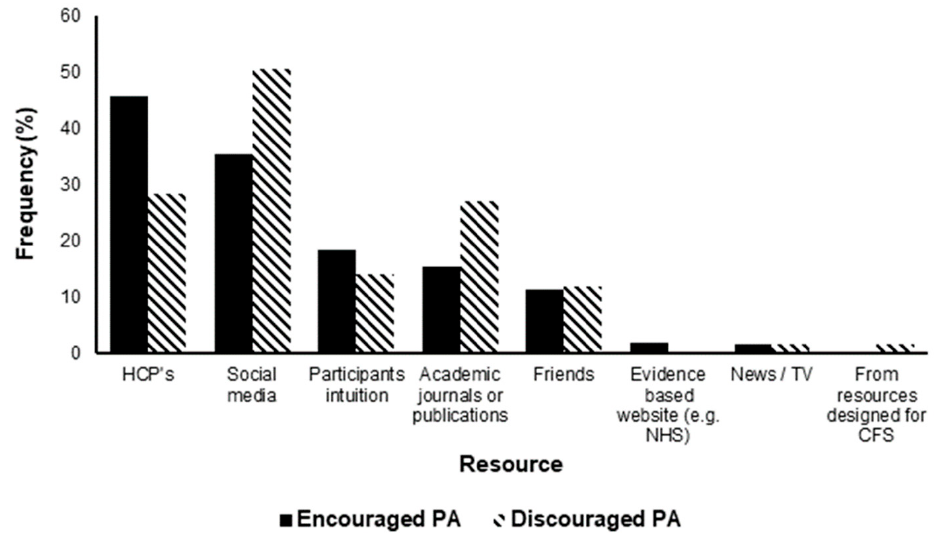
Figure 4. The frequency (%) that resources have encouraged and/or discouraged physical activity (PA) in 477 participants with Long COVID (LC). CFS; chronic fatigue syndrome, HCPs; healthcare professionals.